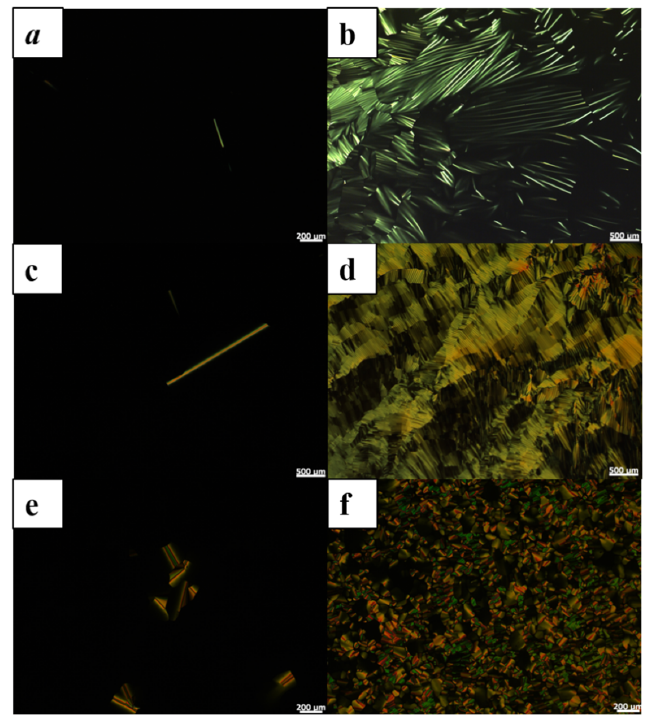
Figure 2. Representative POM photomicrographs (upon cooling from isotropic liquid with a rate of − 5 °C/min): ( a , b ) BBP 8, before and after mechanical shearing at 255 °C; ( c , d ) BBP 12, before and after mechanical shearing at 220 °C; ( e , f ) DBP 8, before and after mechanical shearing at 130 °C and 175 °C.